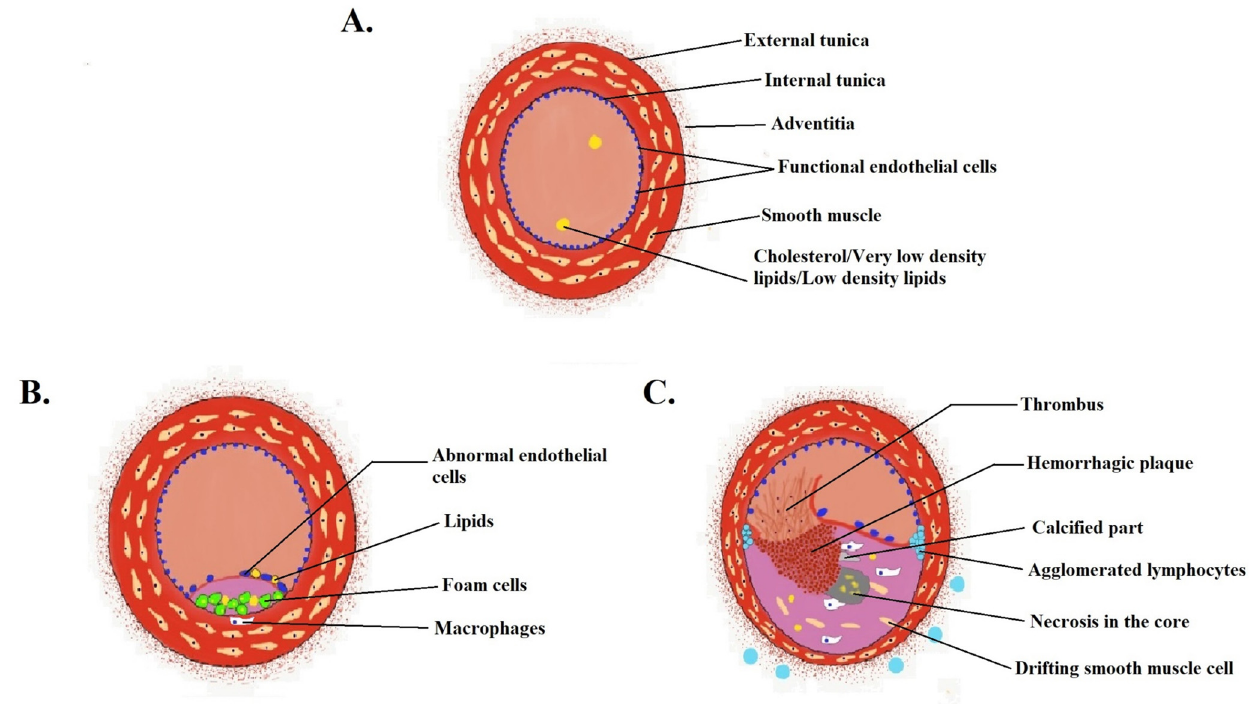
Figure 3. Pathophysiology of atherosclerosis. ( A ) The normal arteriole wall can be seen with fewer lipids in circulation. ( B ) Accumulation of lipids, foam cells, and macrophages leads to atherosclerotic plaque formation. ( C ) The latter stage of atherosclerosis leads to thrombus formation and necrosis in the plaque core which leads to different complications such as thrombosis and stroke.